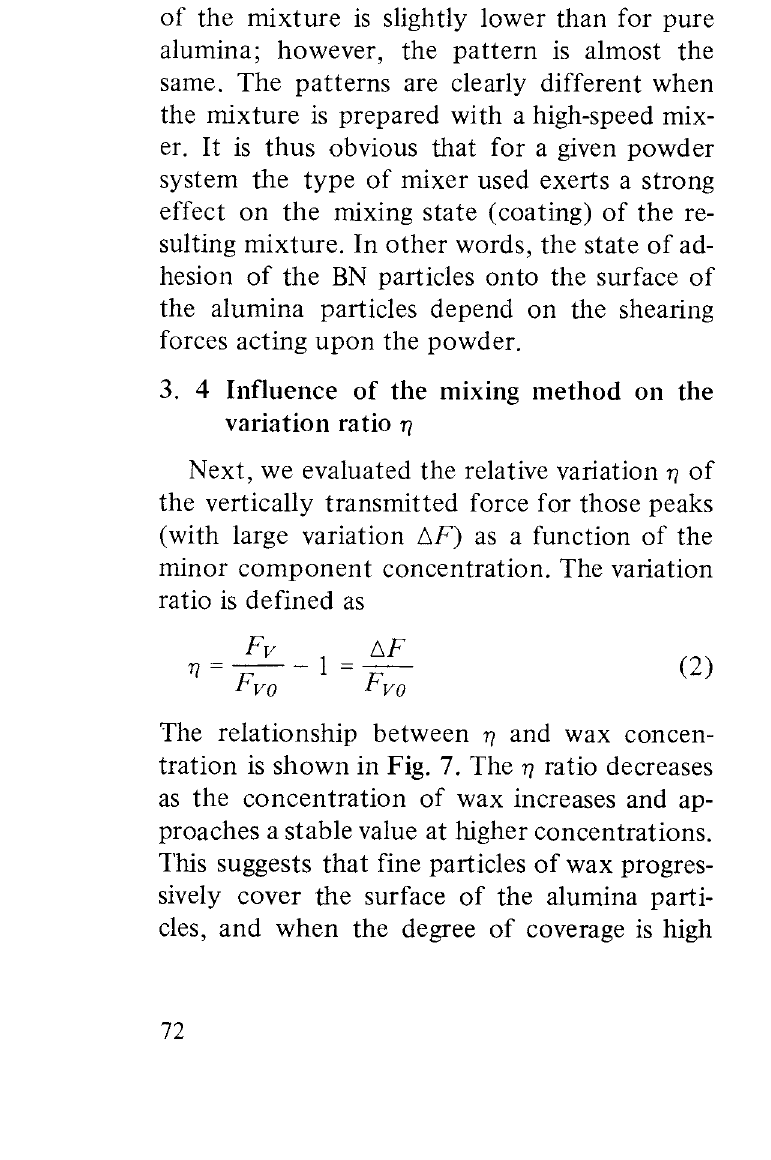
Fig. 7 Relative change of the vertically transmitted force, r;, with concentration of added powder (mixer I) enough or complete, r; attains a stable